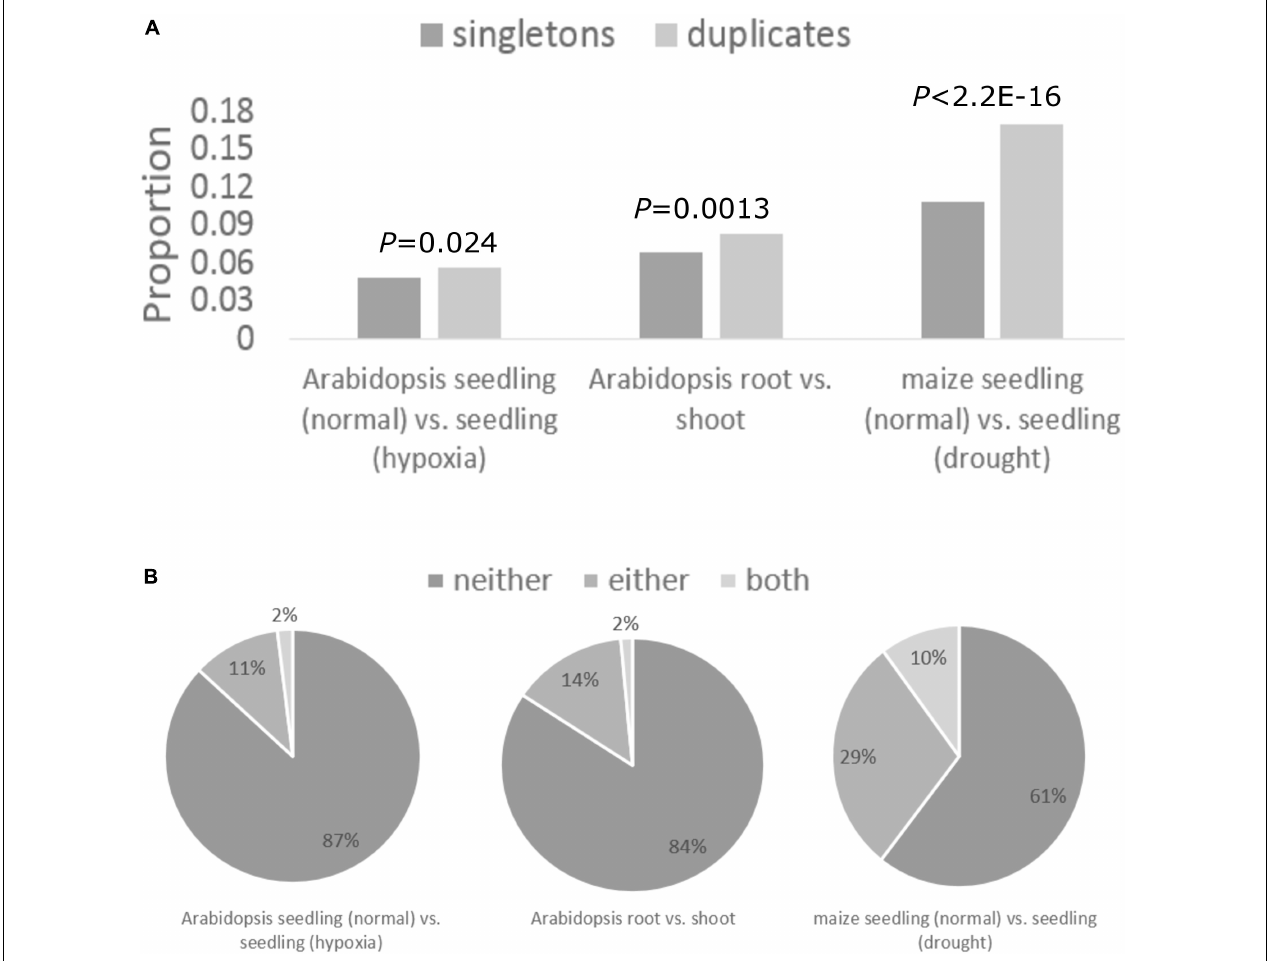
FIGURE 4 | Tissue- and stress-specific translational regulation of WGD duplicates. (A) Proportions of duplicates and singletons that showed differential TE between tissue types or under stress conditions. P -values obtained from the chi-squared test are shown above the bar. (B) Pie charts showing the proportion of WGD duplicates where neither copy (referred to as “neither”), one copy (referred to as “either”), and both copies (referred to as “both”) showed differential